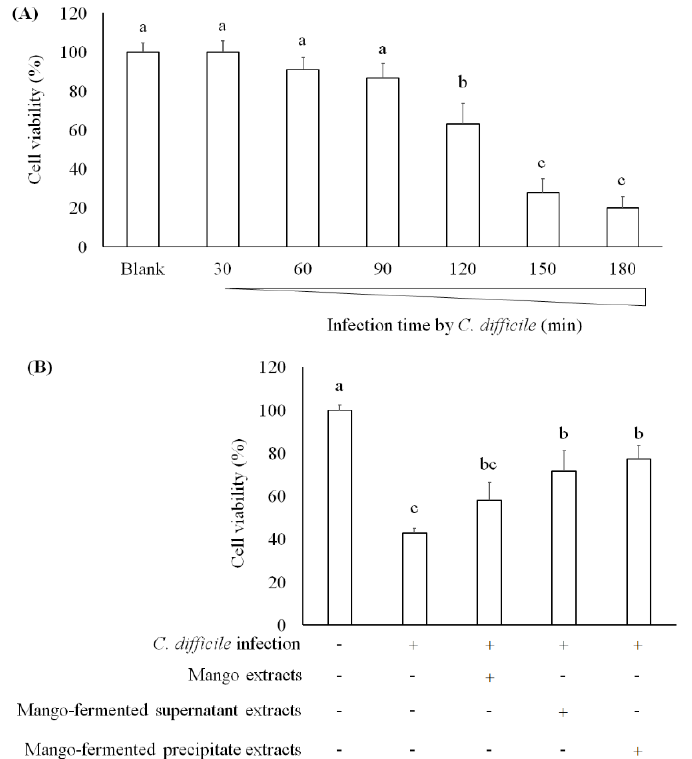
Figure 4. The effect of mango-fermented extracts on the cell viability in Caco-2 cells: ( A ) cell viability was markedly decreased in cells after C. difficile infection for 2 h; ( B ) the protection of L. acidophilus BCRC14079-fermented mango against C. difficile infection in Caco-2 cells. Data are shown as means ± SD ( n = 3). Significant difference was shown by various letters ( p < 0.05). Symbol + means this sample is added to the group, and symbol − means this sample is not added.